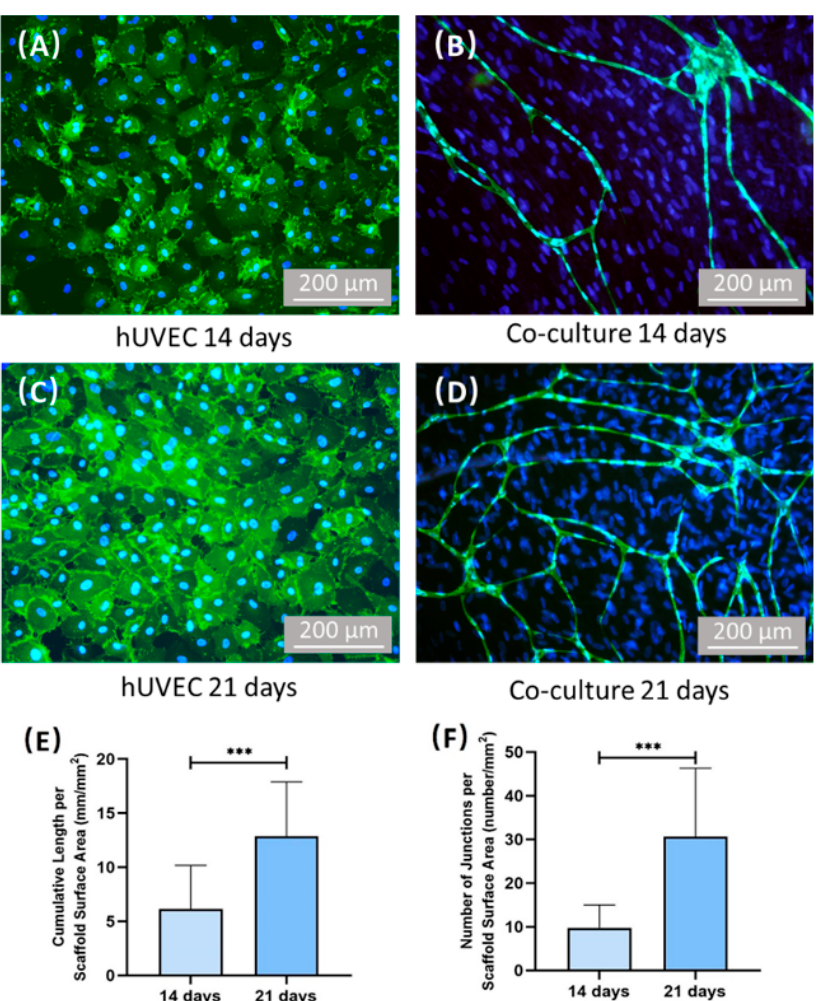
Figure 6. Images of CD31 immunostaining and quantification of vessel length/junctions. hUVECs were identified by immunostaining with CD31 in green on the cell membrane, and the nuclei were stained with DAPI in blue. hPDLSCs were stained by nuclei counterstaining with DAPI in blue but without green stains on the cell membrane. ( A ) hUVEC group at 14 days, ( B ) co-culture group at 14 days, ( C ) hUVEC group at 21 days, ( D ) co-culture group at 21 days, ( E ) quantification the vessel length of co-culture group, ( F ) quantification the vessel junctions of co-culture group. For hUVEC group, no capillary-like structure can be found after culturing 14 days. Co-culture group formed capillary-like structures after culturing 14 days. Additionally, the vessel length and vessel junction number of co-culture group increased with time. *** p <